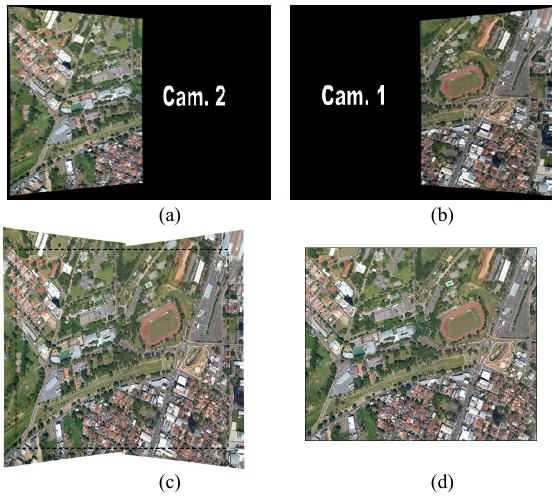
Figure 1. Resulting rectified images of dual cameras: (a) left image from camera 2 and, (b) right image from camera 1 (c) resulting fused image from two rectified images after registration and, (d) cropped without the